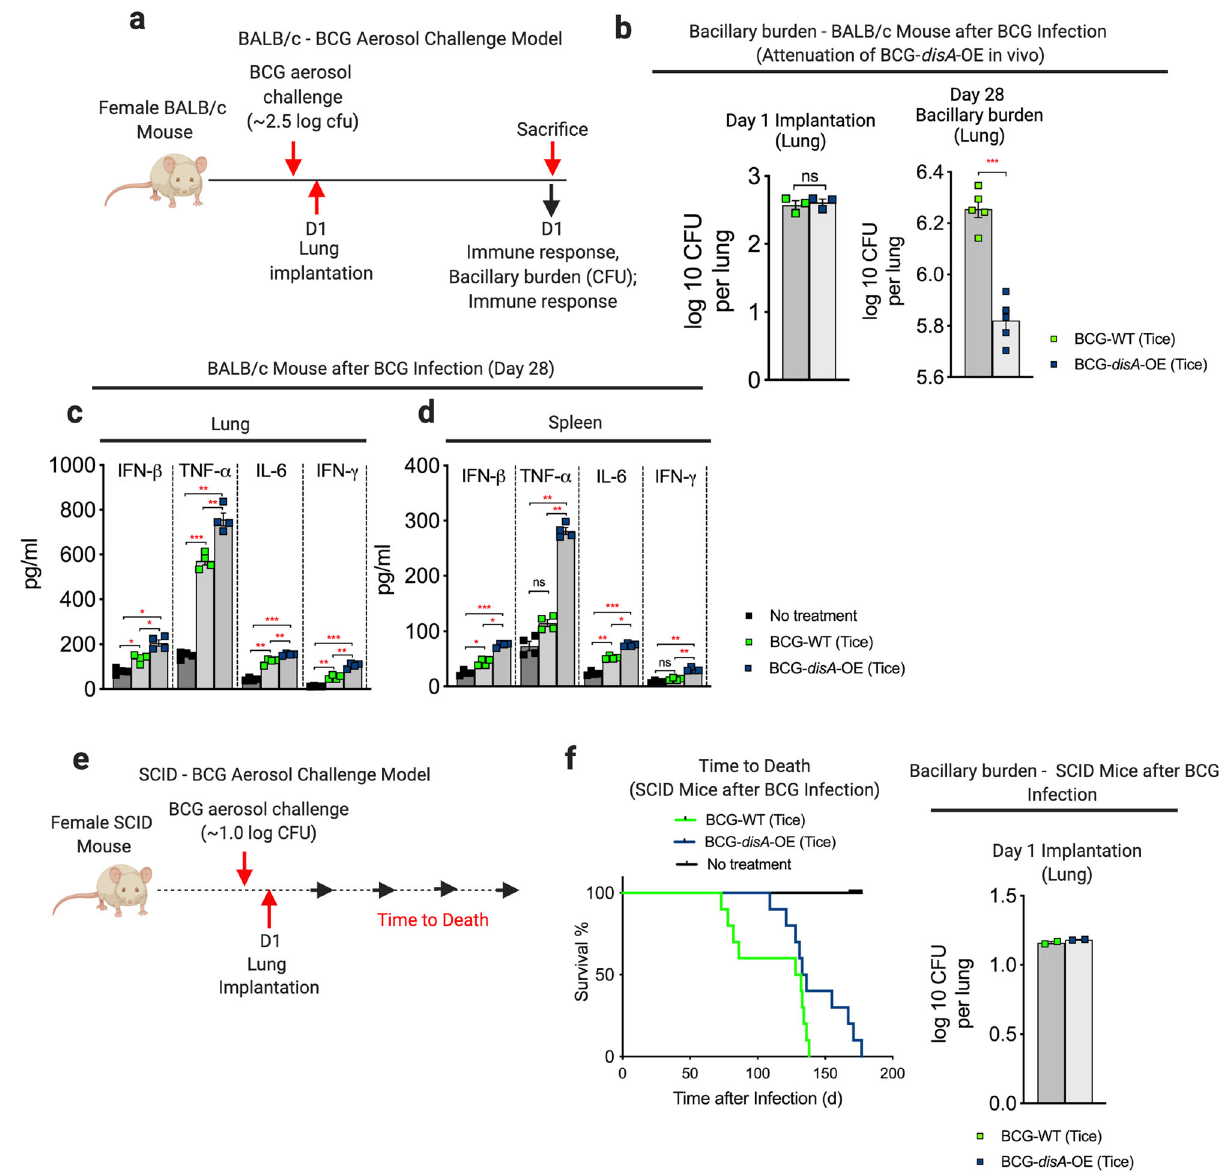
Fig. 7 BCG- disA -OE is less pathogenic than BCG-WT in two mouse models and elicits a greater pro-in fl ammatory cytokine levels in vivo. a Schematic diagram of the immunocompetent BALB/c mouse challenge model. b Lung colony forming unit (CFU) counts at day 1 ( n = 3 animals/group) and day 28 ( n = 5 animals/group). Data are represented as mean values ± S.E.M. c Levels of the pro-in fl ammatory cytokines IFN- β , TNF- α , IL-6, and IFN- γ in mouse lungs and d spleens determined by ELISA at day 28 ( n = 4 animals/group). Data are mean values ± S.E.M. e Schematic diagram of the immunocompromised SCID mouse challenge model. f Percent survival of SCID mice following low-dose challenge ( n = 10 animals/group). The day 1 lung CFU counts are shown at right ( n = 2 animals/group). All statistical analyses done using two-tailed Student ’ s t -test (* P <0.05, ** P < 0.01, *** P < 0.001, **** P <